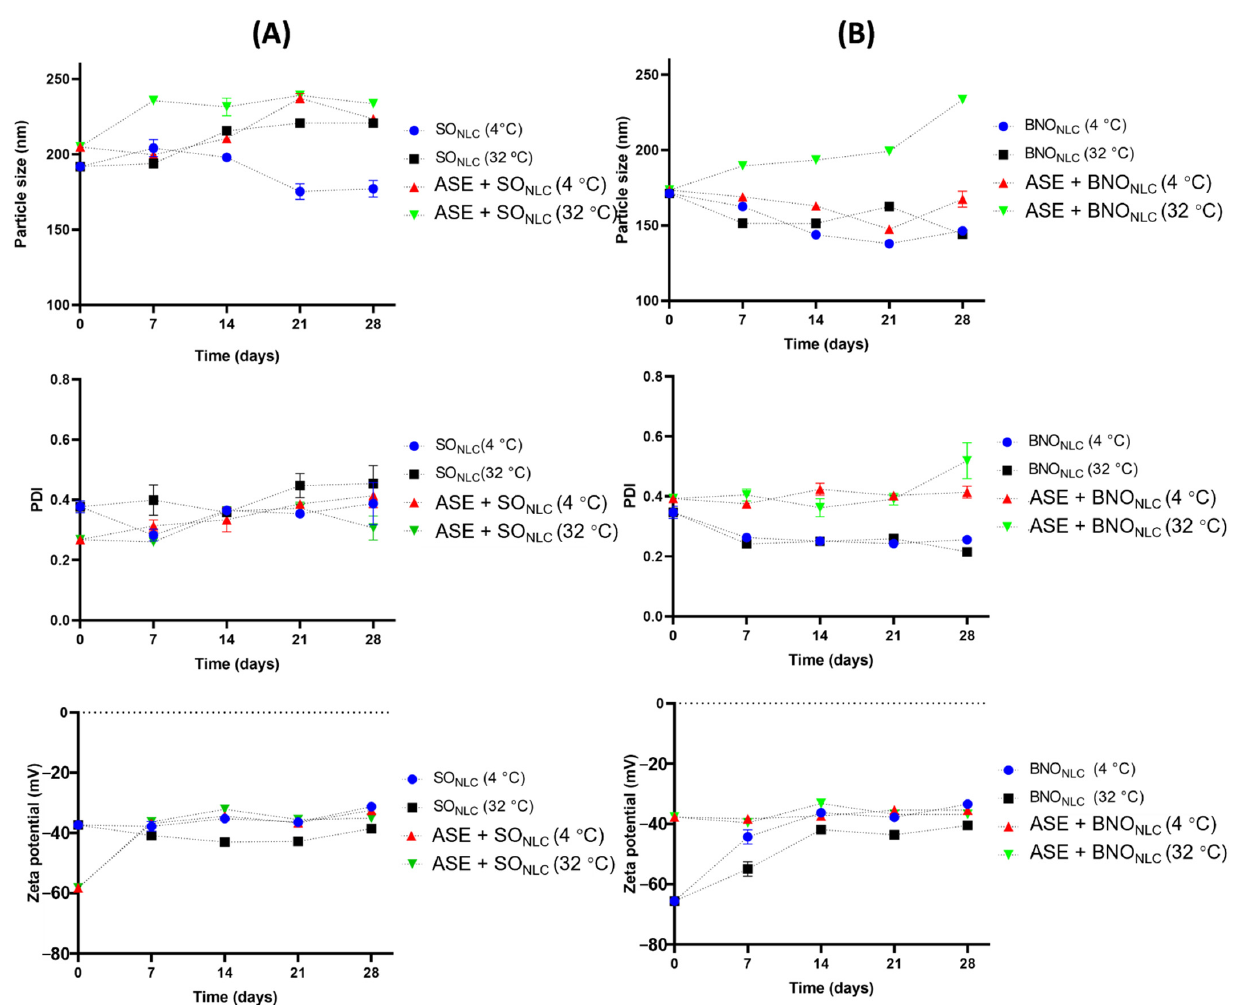
Figure 3. ( A ) Particle size, PDI, and zeta potential of the SO NLC and ASE + SO NLC stored at tempera- tures of 4 °C and 32 °C. ( B ) Particle size, PDI, and zeta potential of the BNO NLC and ASE + BNO NLC stored at temperatures of 4 °C and 32 °C.